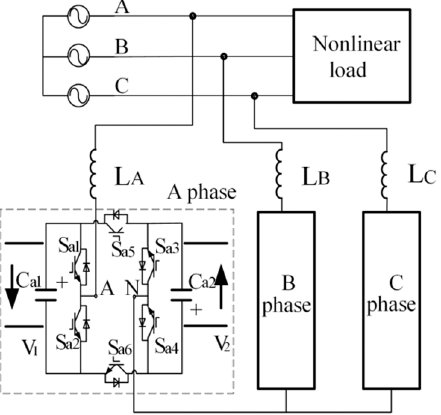
Figure 1. Seven-level active power filter (APF) main circuit.